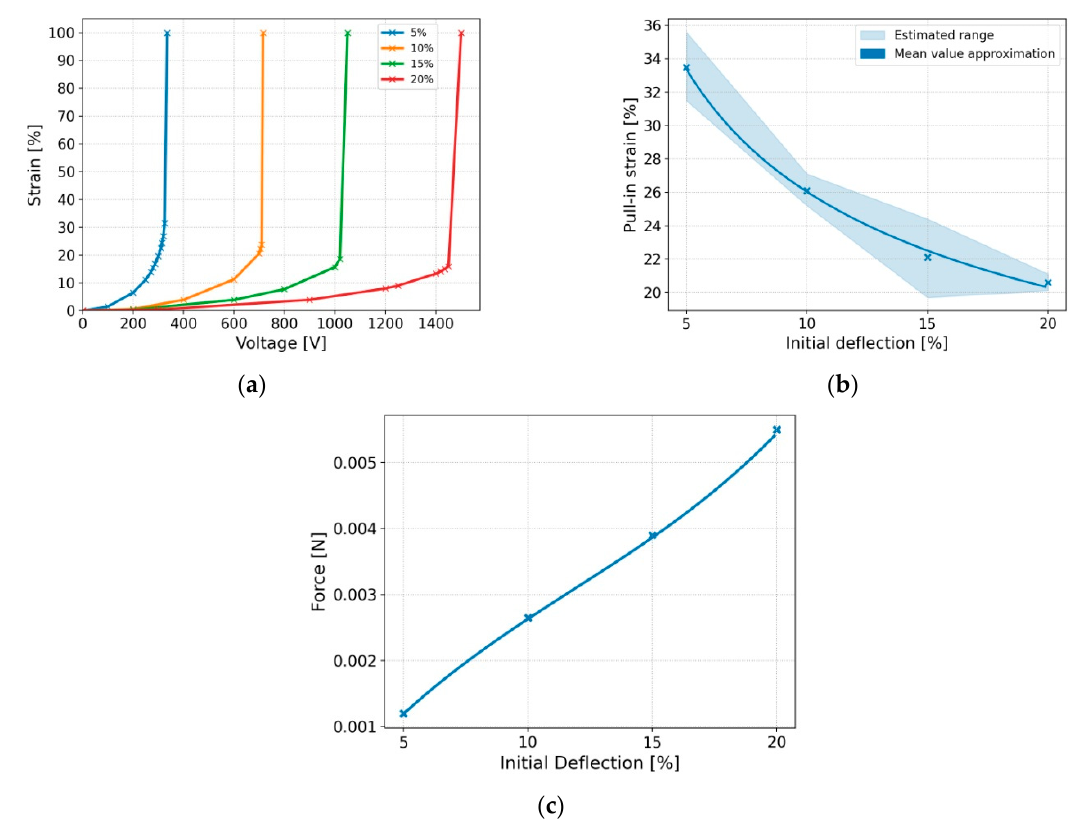
Figure 7. ( a ) Strain-voltage characteristics for 4 types of initial deflection of the actuator; ( b ) Pull-in strain-initial deflection characteristic of the actuator; ( c ) Force-initial deflection characteristic of the actuator.